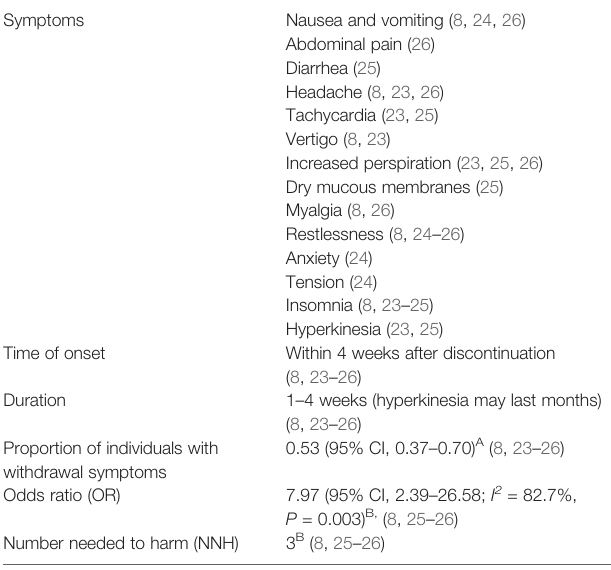
TABLE 2 | Clinical features of abrupt oral antipsychotic